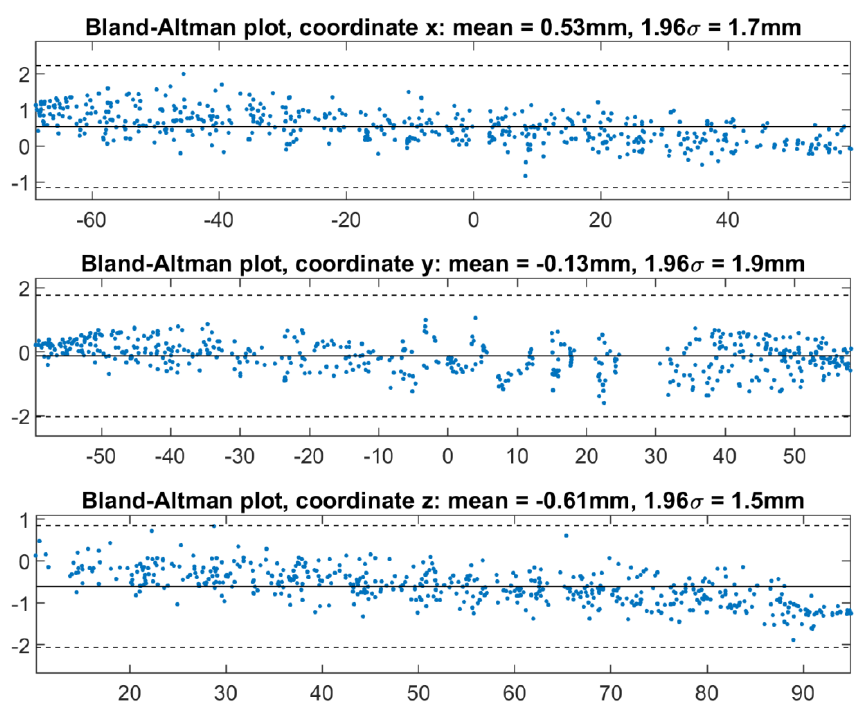
Figure 7. Bland – Altman plots of the coordinate differences between PhotoMeDAS and CNC CMM Figure 7. Bland–Altman plots of the coordinate differences between PhotoMeDAS and CNC CMM (ground truth). (ground